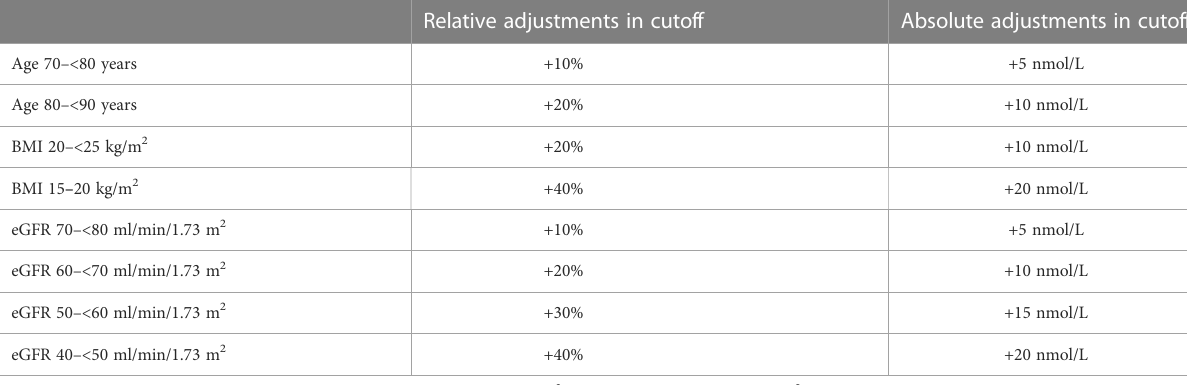
Table 5 Suggested percentual or absolute adjustments of the established cutoff level of 50 nmol/L for considering cortisol DST to be elevated. Relative adjustments in cutoff